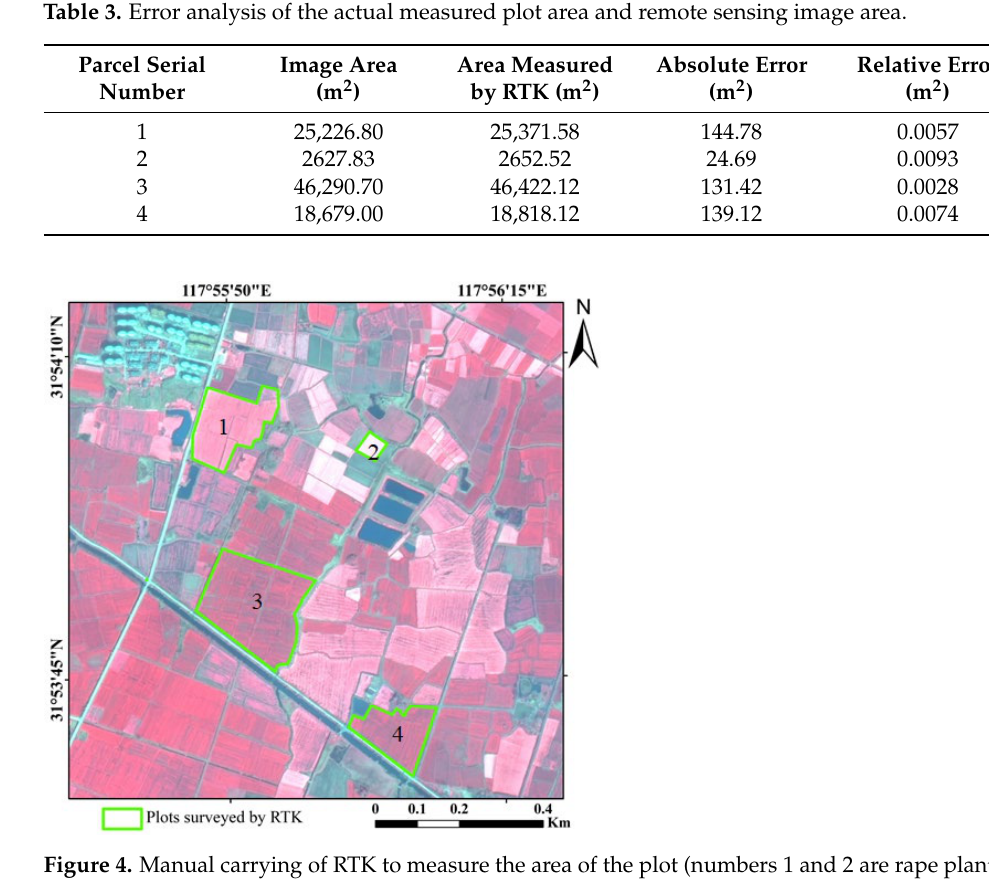
Figure 3. UAV survey area. (These data were not included in the experiment and were only used for fine confirmation of feature types and to enhance the reliability of sample establishment.).